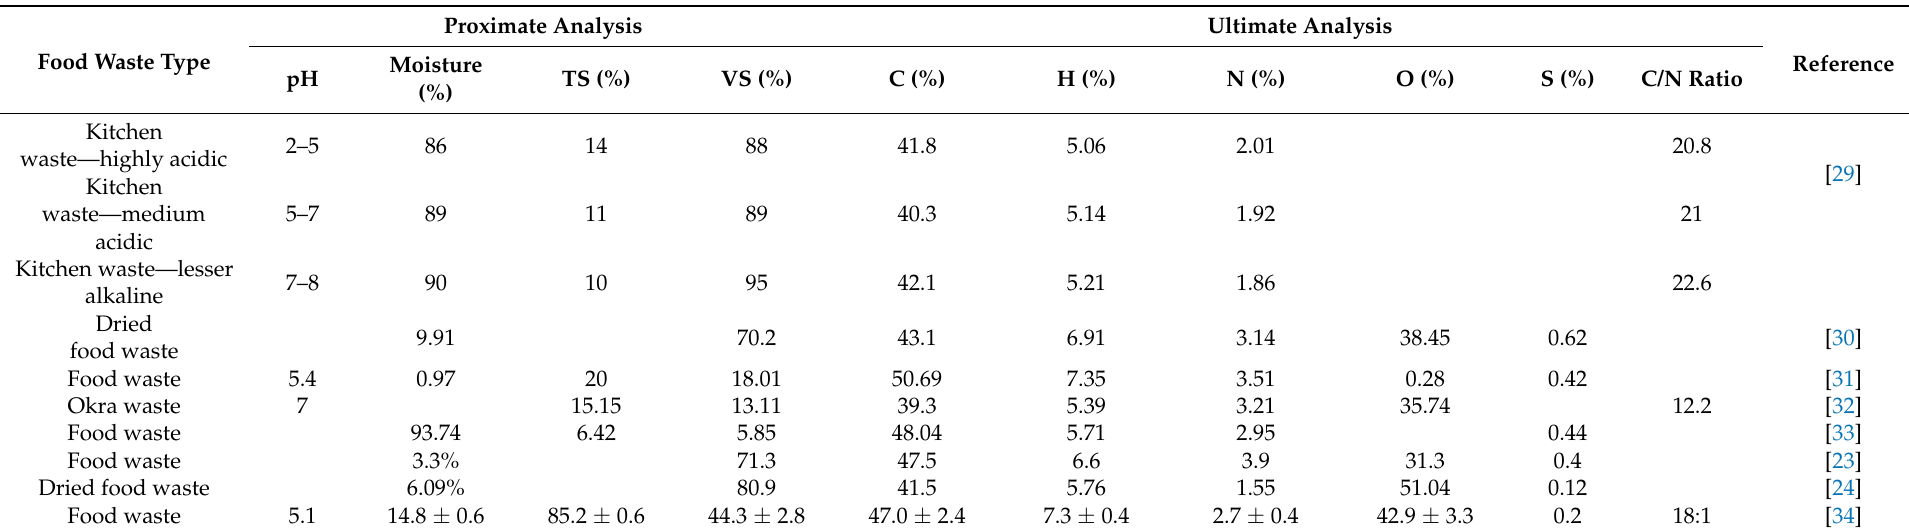
Table 2. Proximate and ultimate analysis of food